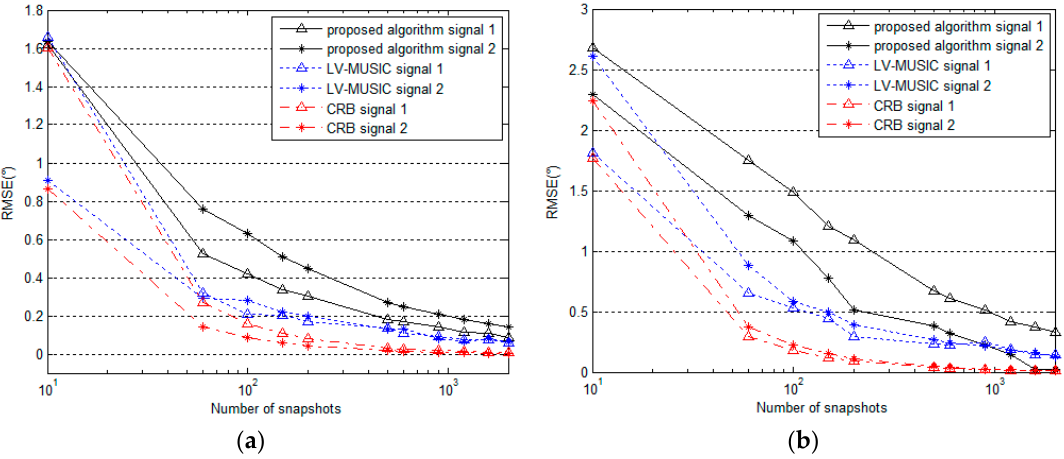
Figure 11. RMSE of ( a ) polarization auxiliary angle and ( b ) polarization phase difference estimation versus number of snapshots (for SNR = 20 dB).